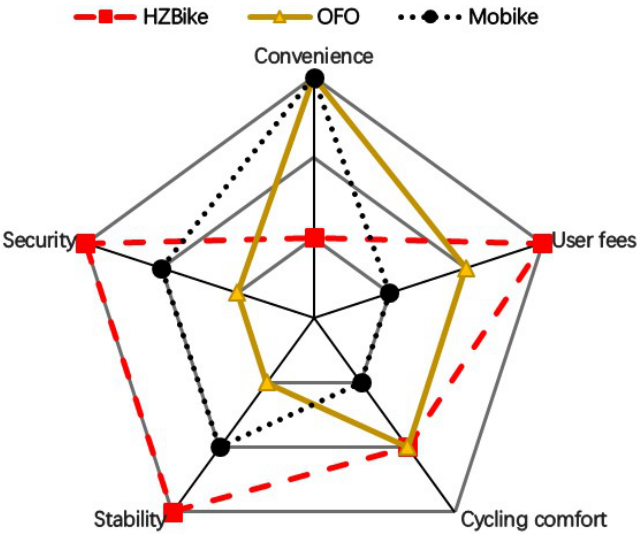
Figure 4. Comparison among HZBike, Mobike,